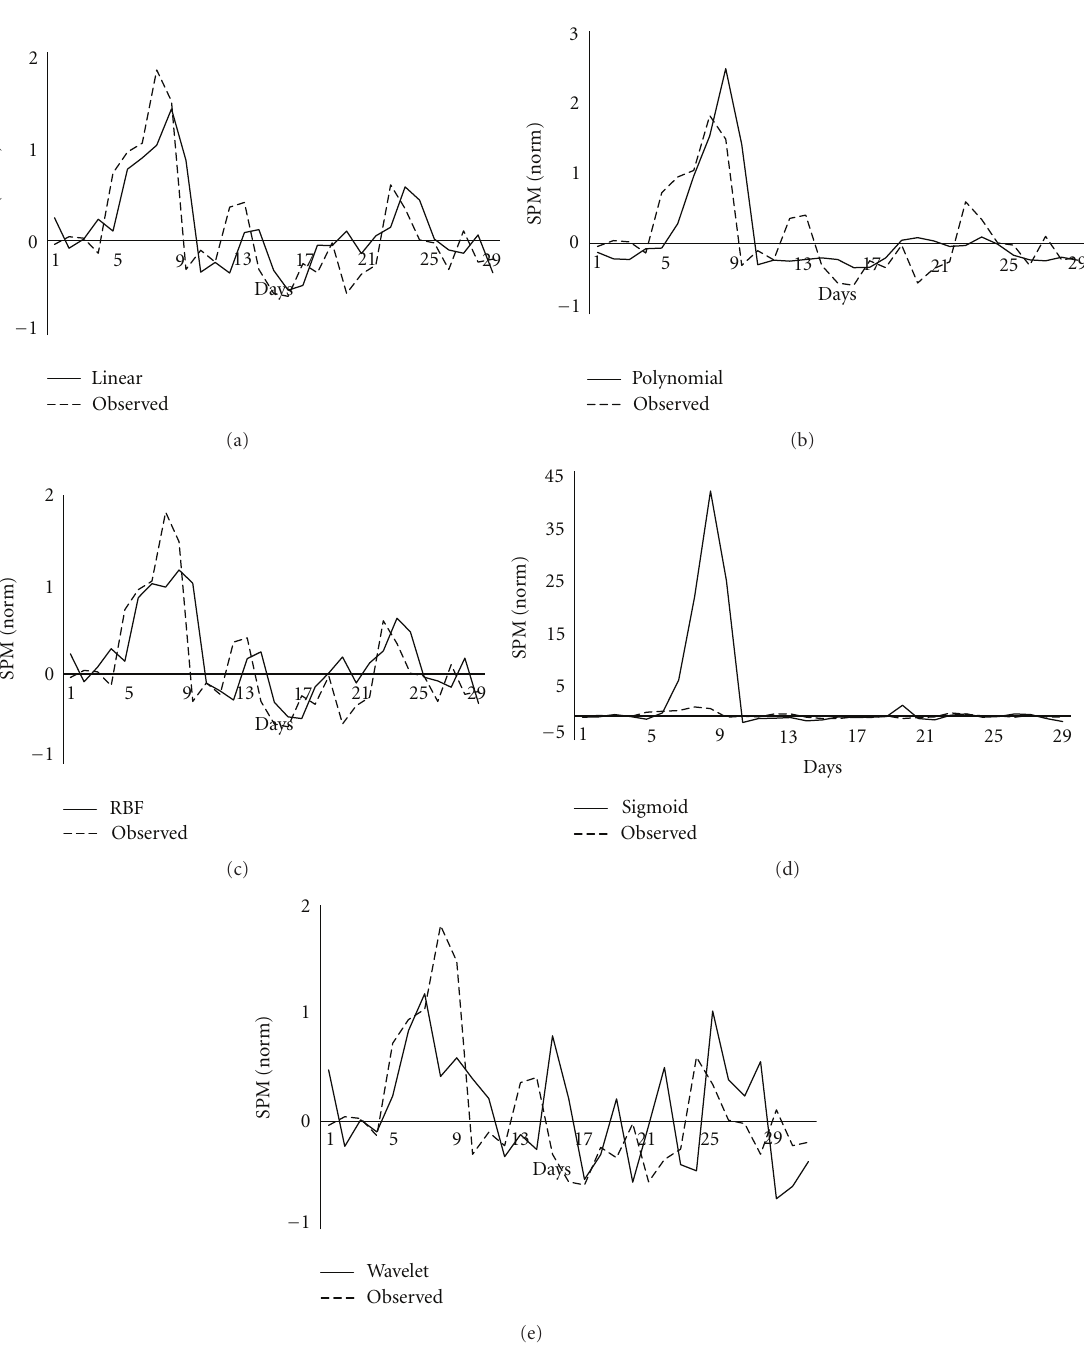
Figure 5: The predicted and observed levels of SPM using di ff erent kernel models in winter experiment